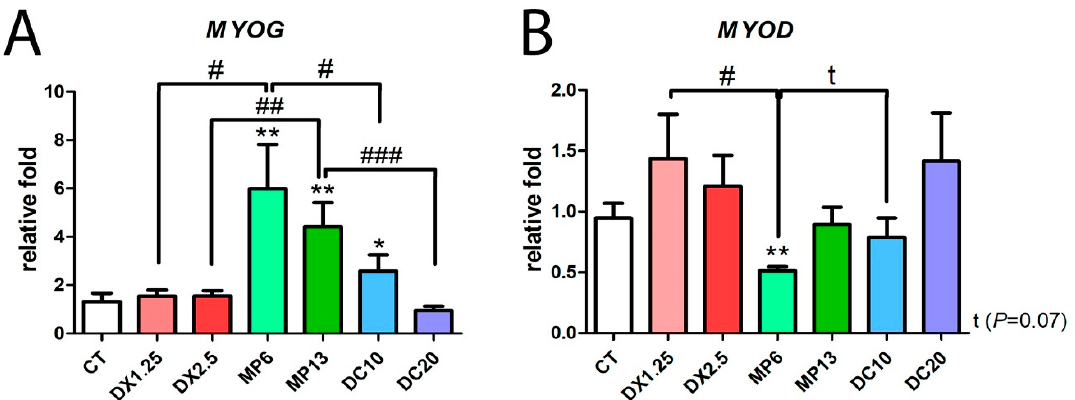
Figure 6. mRNA expression by RT-PCR of MyoG ( A ) and MyoD ( B ) after the administration of di ff erent glucocorticoids. (*) represents the statistical di ff erence in comparison to the CT, and (#) represents statistical di ff erence between groups. Legend: * or # = P < 0.05; ** or ## = P < 0.01 and ### = P < 0.001. ( n per group: CT = 10, DX1.25 = 9, DX2.5 = 8, DC10 = 10, DC20 = 10, MP13 = 8, MP6 =